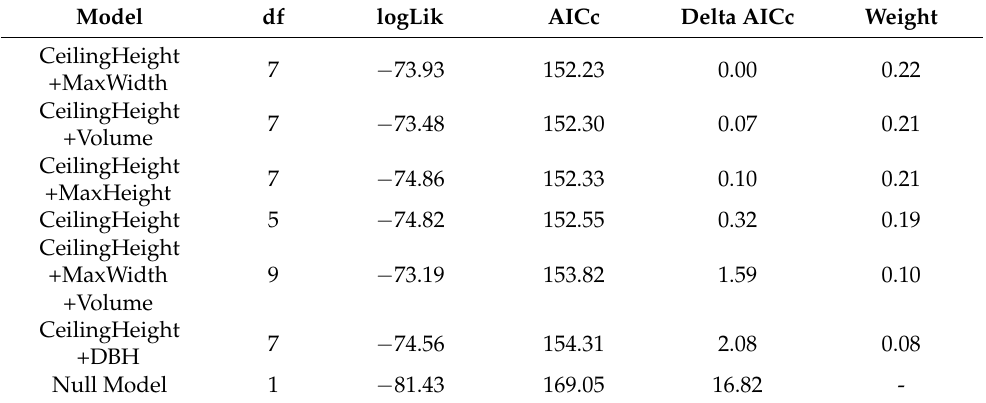
Table 3. Generalized Additive Mixed Model (Program R, “mgcv” package) rankings based on Akaike’s Information Criterion corrected for smaller sample sizes (AICc; hollow predictors versus guano mass response). A Gaussian family smoothing function was used with the “identity” link function (n = 131). CeilingHeight = height from top of opening to ceiling; MaxWidth = maximum width of hollow opening; Volume = calculated cone shape inside of hollow; MaxHeight = maximum height of hollow opening; DBH = Diameter at Breast Height.